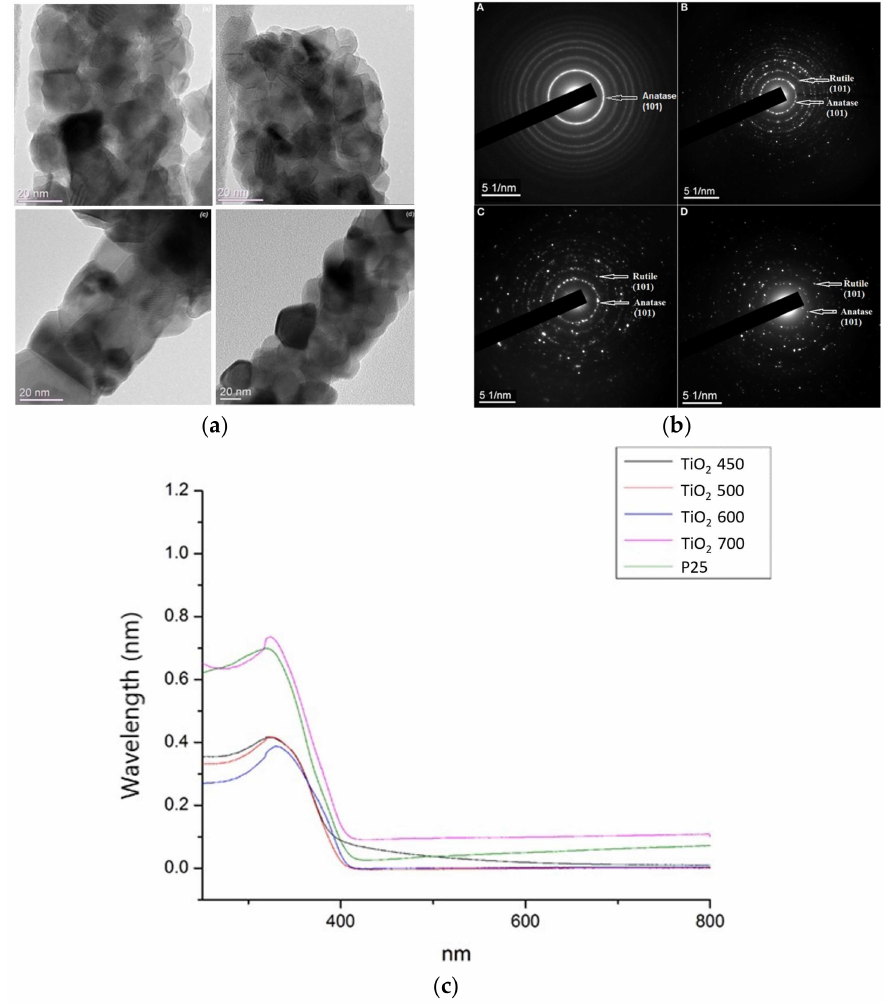
Figure 10. ( a ) TEM images of TiO 2 nanogrids at 450 ◦ C, 500 ◦ C, 600 ◦ C, and 700 ◦ C; ( b ) SAED patterns of TiO 2 nanofibers annealed at 450 ◦ C, 500 ◦ C, 600 ◦ C, and 700 ◦ C [43]; ( c ) UV-Vis spectra of P25 and TiO 2 nanofibers annealed at 450 ◦ C, 500 ◦ C, 600 ◦ C, and 700 ◦ C